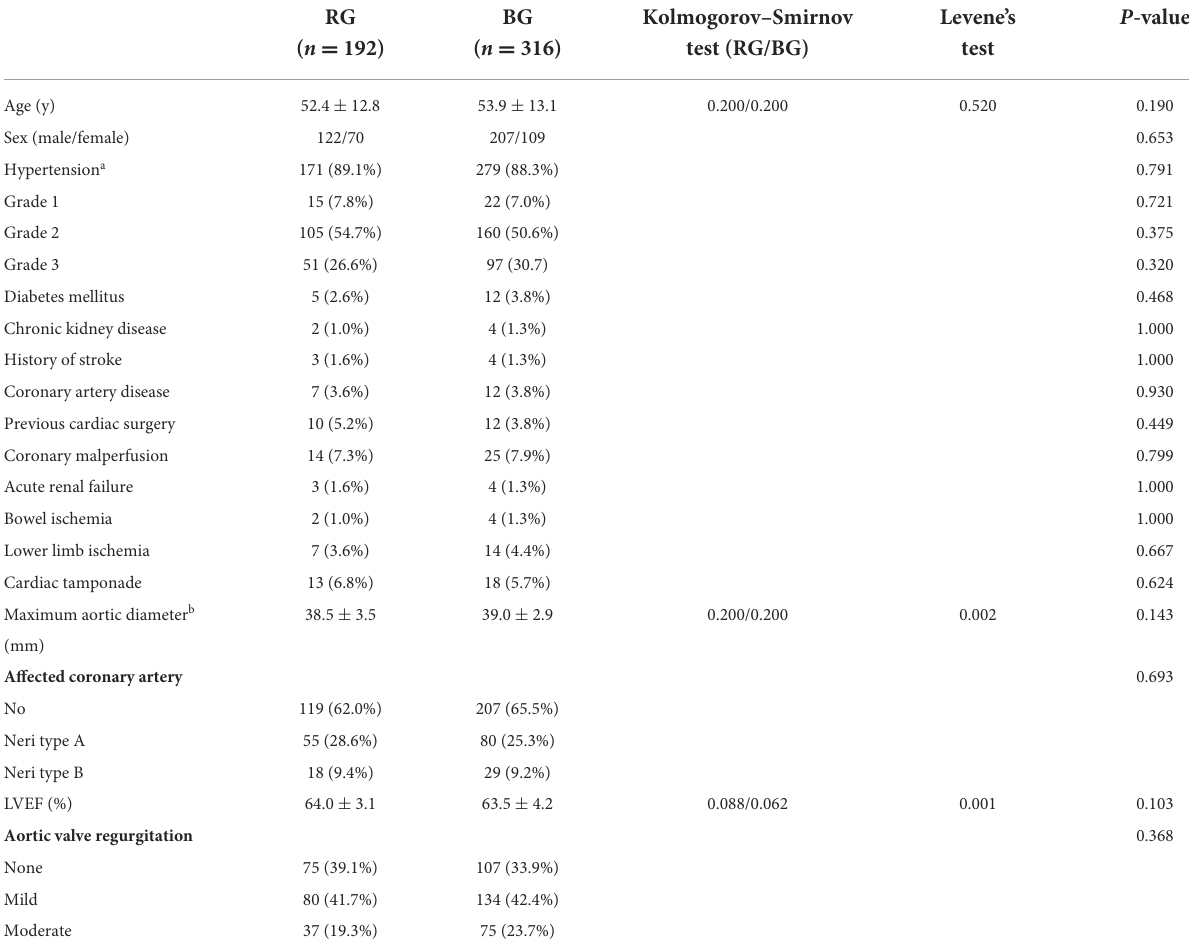
TABLE 1 Preoperative clinical characteristics of the patients.